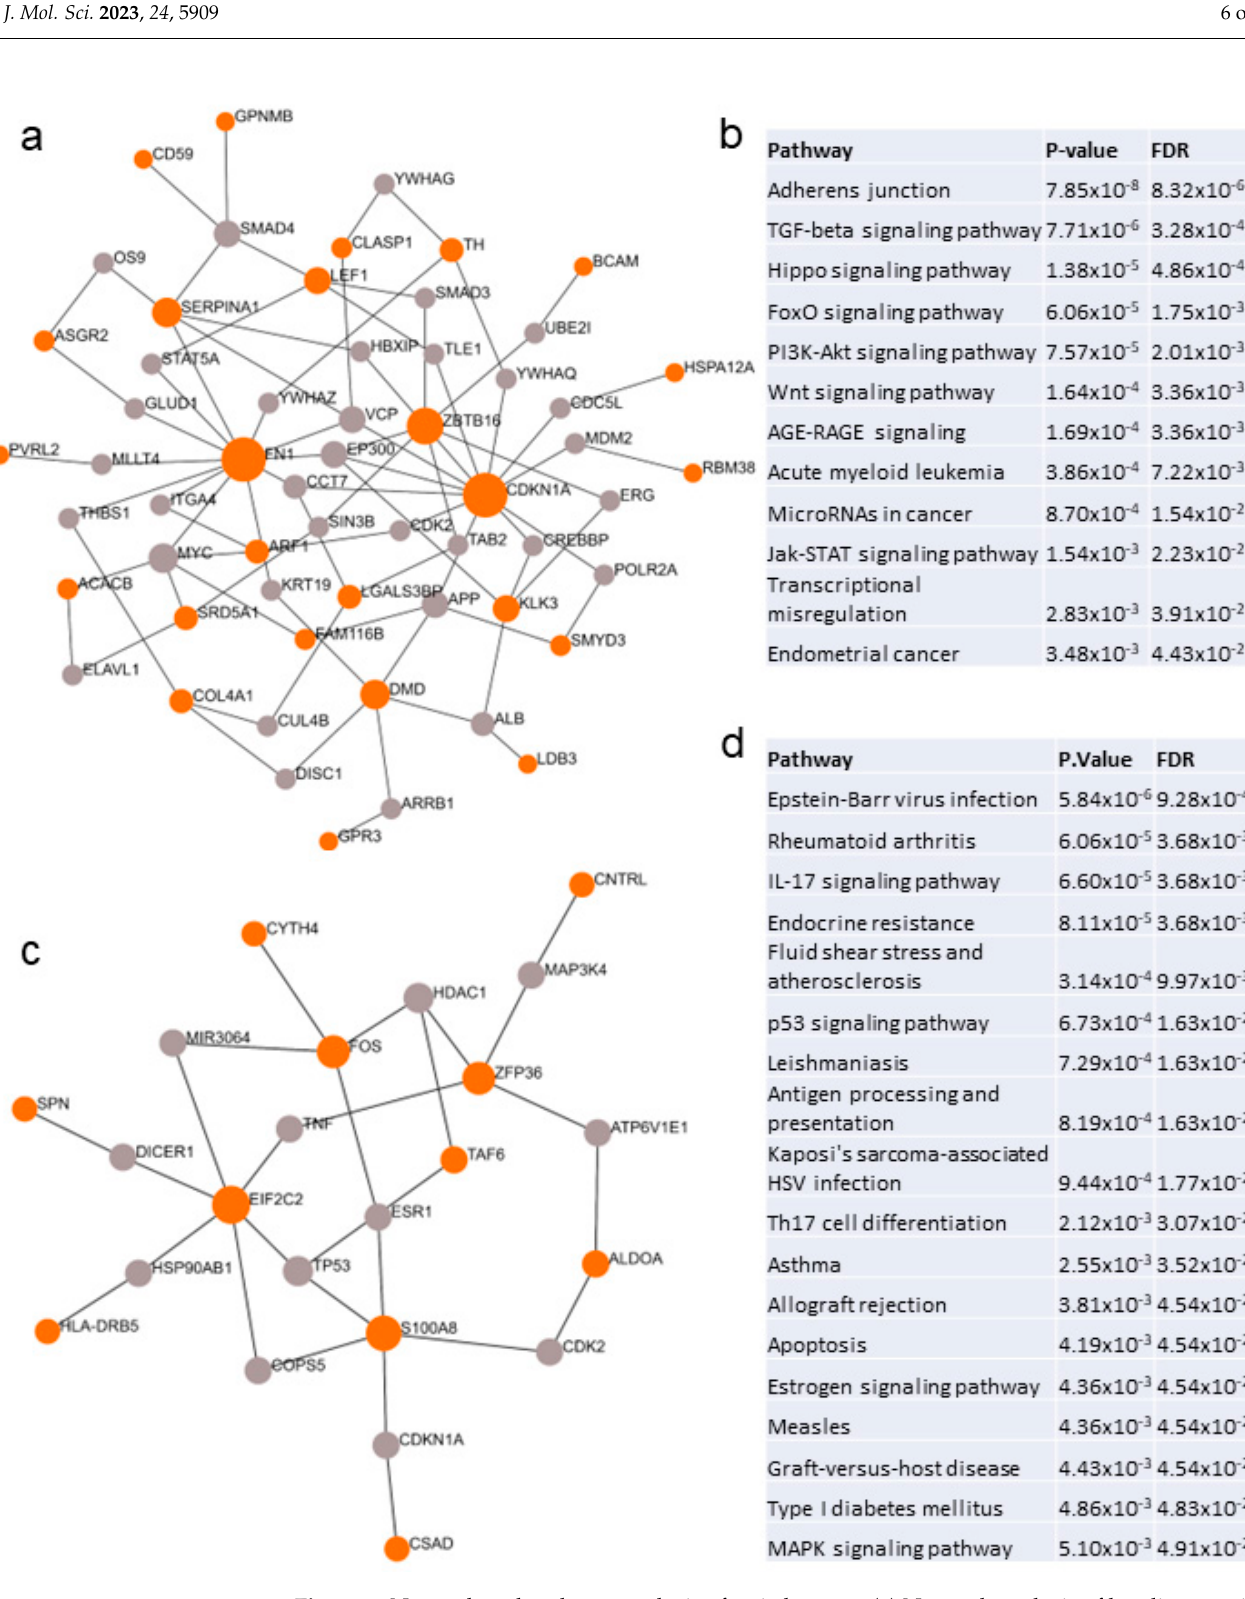
Figure 3. Network and pathway analysis of switch genes. ( a ) Network analysis of loneliness switch genes. Switch genes are depicted in orange and interacting proteins are in gray. ( b ) Unique pathways dysregulated in individuals with chronic loneliness. ( c ) Network analysis of switch genes identified in males with chronic loneliness. ( d ) Unique pathways dysregulated in males with chronic loneliness. Network and pathway analysis was performed in NetworkAnalyst.